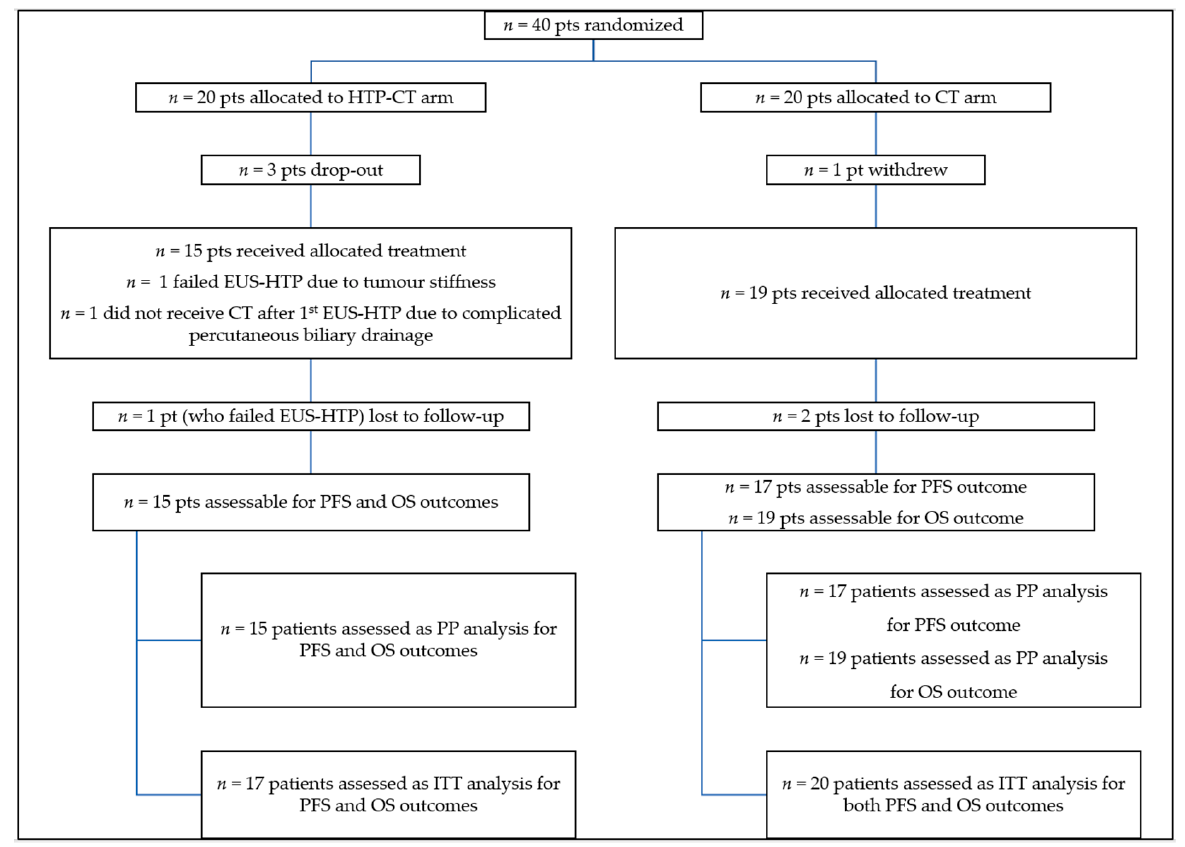
Figure 1. Patients CONSORT flow-diagram. Pts: patients; N: number; HTP-CT: HybridTherm Probe plus Chemotherapy; CT: Chemotherapy; EUS-HTP: endoscopic ultrasound-guided ablation with HybridTherm Probe; PFS: progression-free survival; OS: overall survival; PP: per-protocol; ITT: